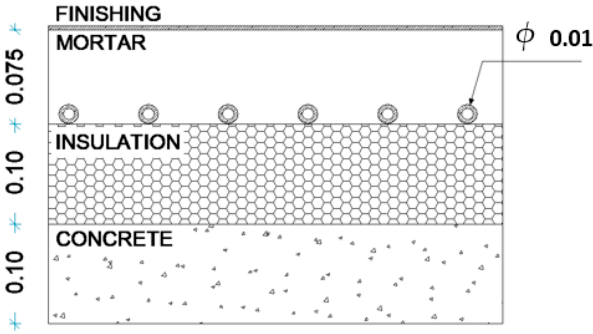
Figure 7. Cross-section of the FE model (dimensions in